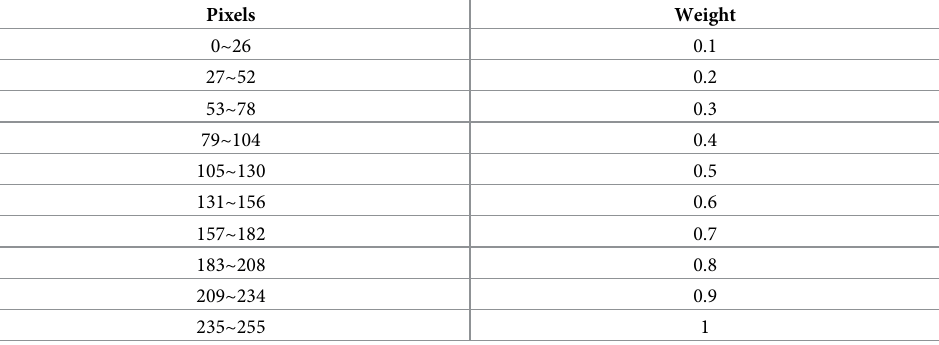
Table 1. The relationship between weight and pixel. Pixels